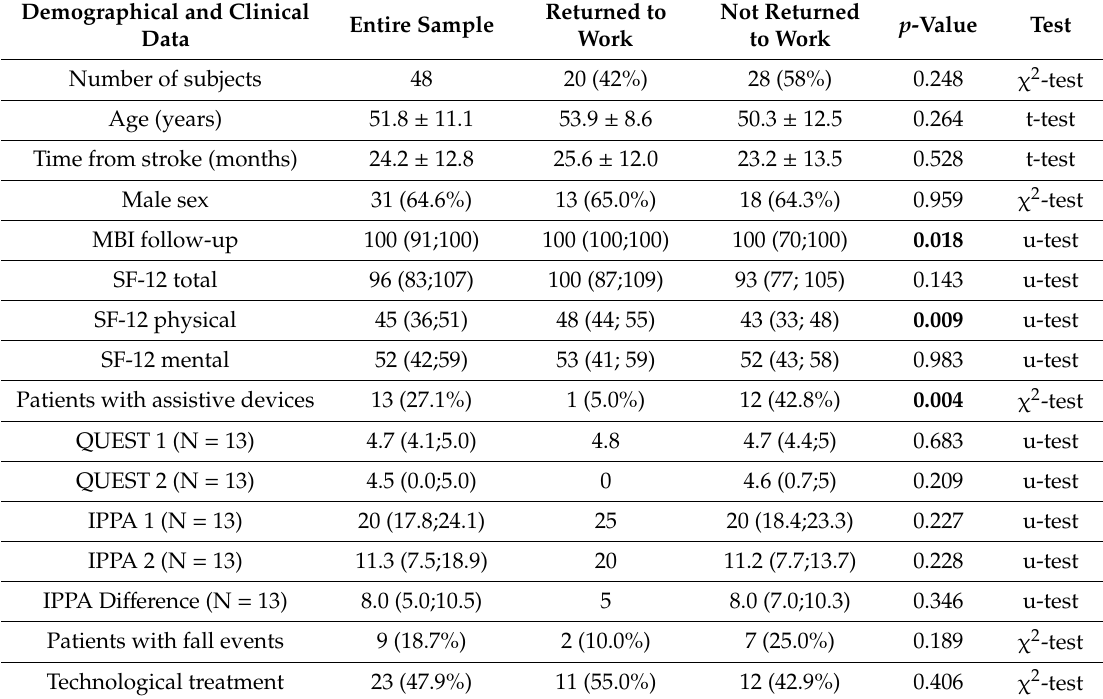
Table 2. Patient data at follow-up: absolute frequency (and percentages) for discrete variables, mean ± standard deviation for continuous variables, median (and first and third quartiles) for ordinal data. The p -values (in bold if statistically significant) refer to the comparison between subjects returned and not returned to work computed using the test reported in the last column according to the variable types.